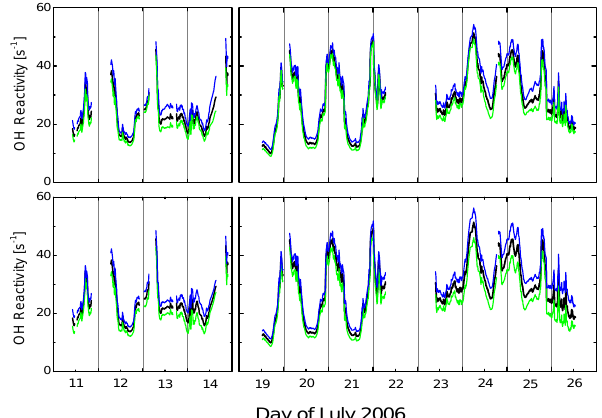
Fig. 8. Sensitivity test of modelled OH reactivities. Upper panel: variation of the OH concentration in the model runs. The black line represents the RACM model (base case) as shown in Fig. 4. The blue and green lines represent model results prescribing twice and half of the OH concentrations calculated in the base case run, respectively. Lower panel: variation of the deposition lifetime of modelled species. Black line: 24h lifetime (base case); blue line: 48h lifetime; green line: 12h lifetime. Vertical lines denote mid-